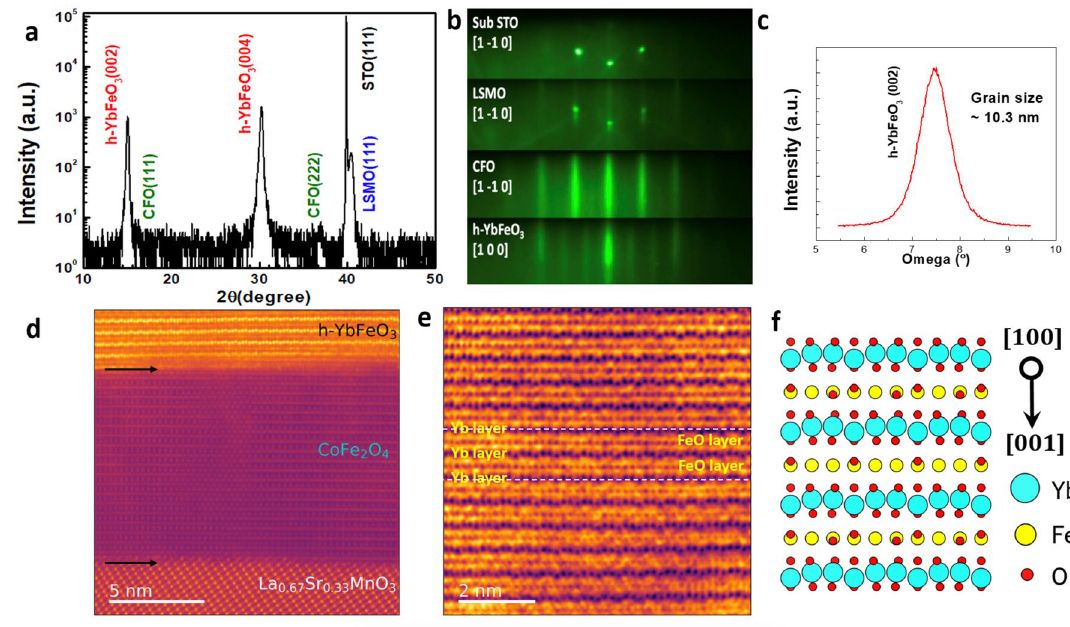
Figure 2. ( a ) θ -2 θ XRD scan of h-YbFeO 3 /CFO/LSMO/STO(111) films. ( b ) RHEED patterns and in-plane epitaxy relationship of individual layer, with electron beam along the h-YbFeO 3 [100] direction. ( c ) Rocking curve of the h-YbFeO 3 (002) peak. ( d ) Cross-section HADDF-STEM of h-YbFeO 3 /CFO/LSMO/STO(111) films, along the